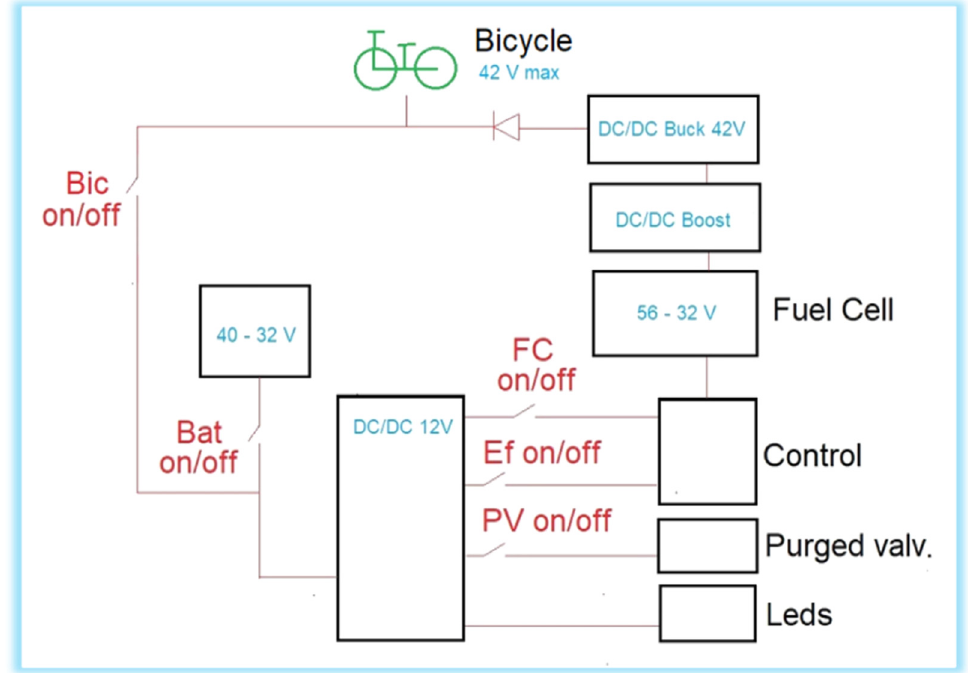
Figure 4. Single-line diagram of the electrical circuit of the electric bicycle.